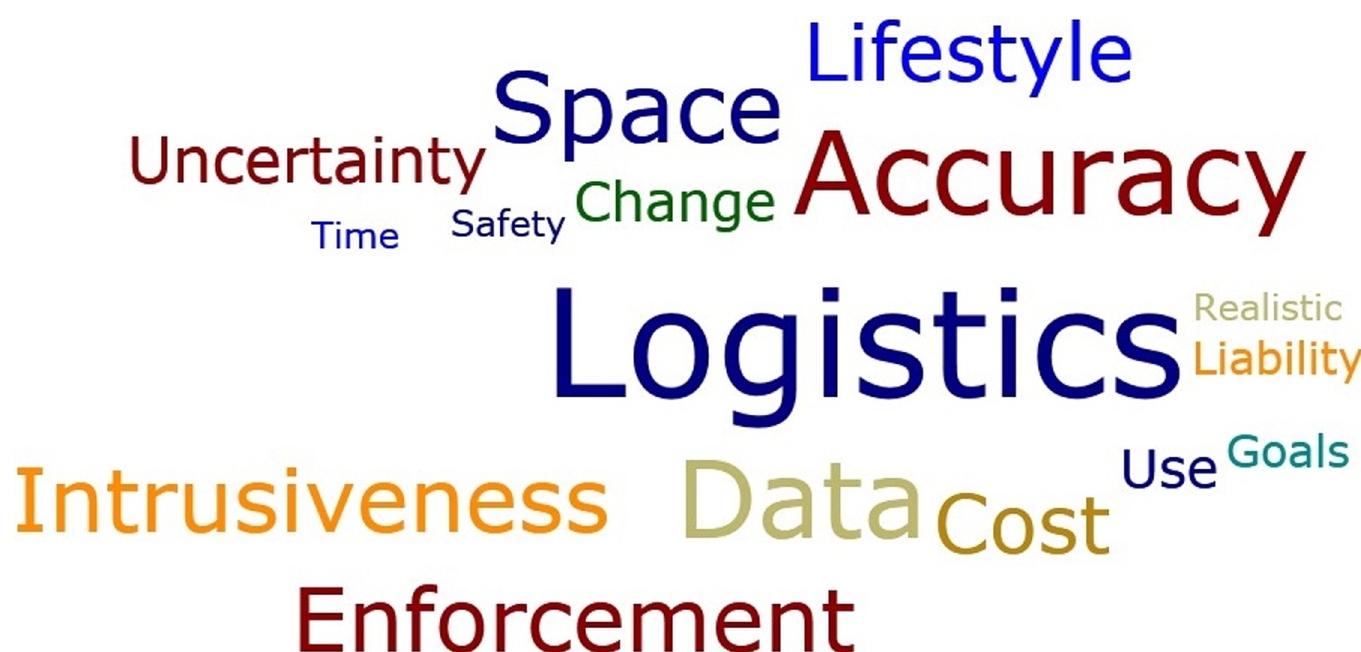
Fig 5. A word cloud created in the Atlas.ti program presents 16 unidirectional criteria themes arranged by size, according to their weight—how often each one was mentioned during interviews. Note that color has no intended significance in this figure.